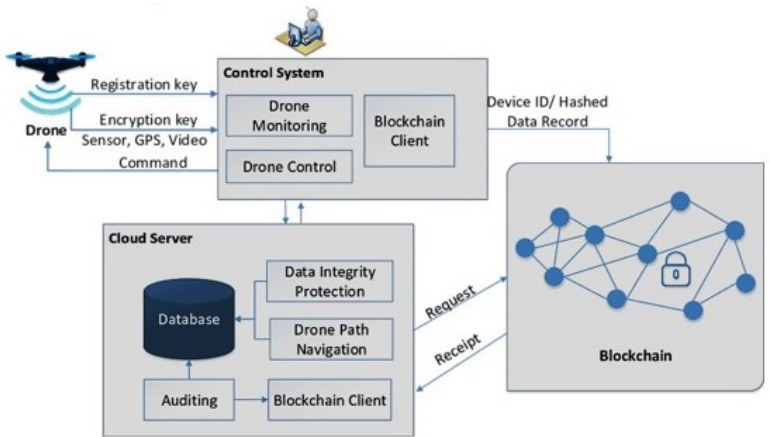
Figure 4. Blockchain-based communication for a